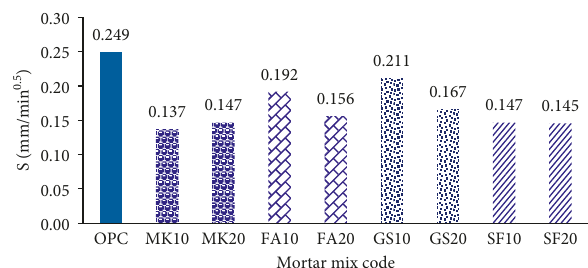
Figure 5: Sorptivity, S (mm/min 0.5 ), of mortars containing SCM, at 28 days.